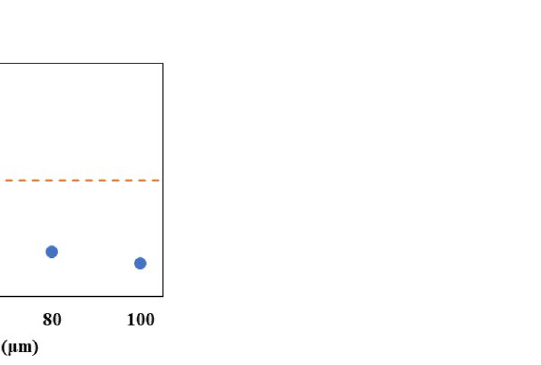
Figure 4. Schematic diagram of the optical setup to measure the power of THz wave. Inset shows the DAST crystals mounted on the crystal holders.